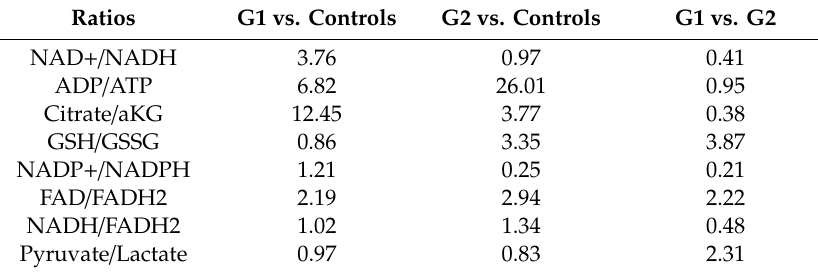
Table 1. Important metabolic ratios that decipher the MDS metabolome. Ratios G1 vs. Controls G2 vs.